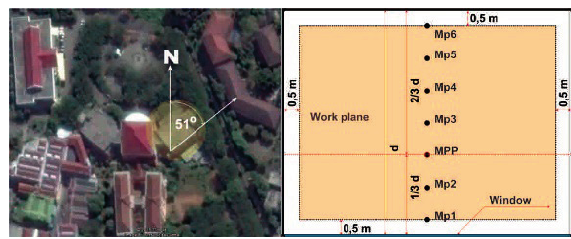
Fig. 1. Windows orientation and measurement point in an